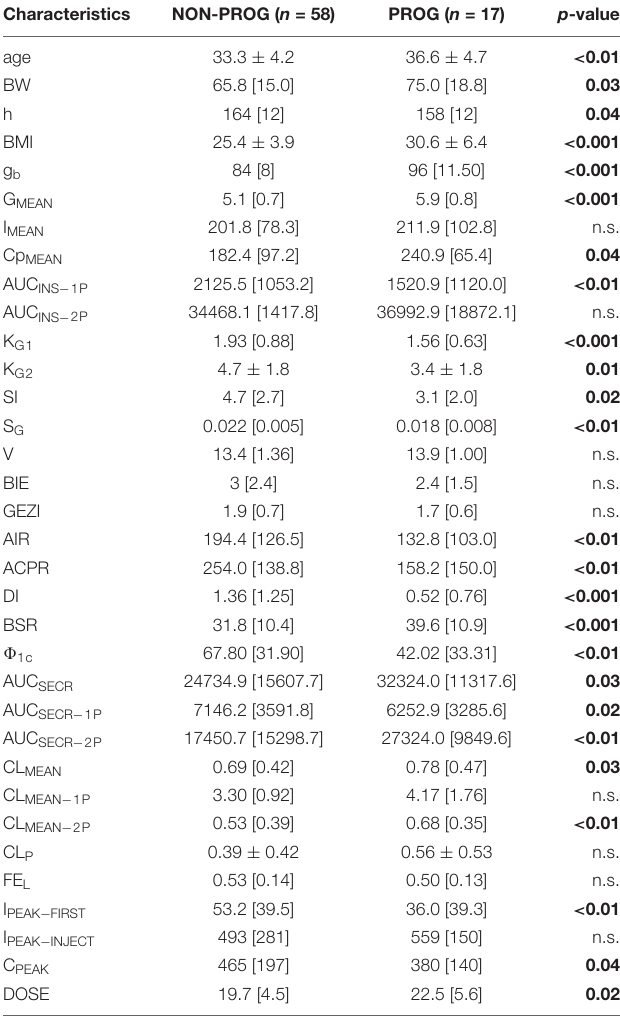
TABLE 2 | Characteristics of the preprocessed data